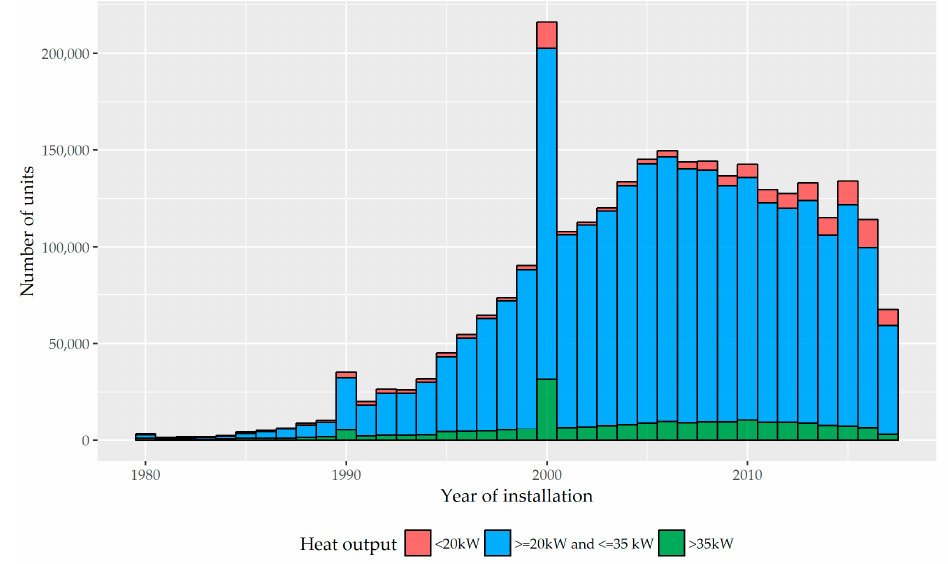
Figure 5. Distribution of heat generators per year of installation.